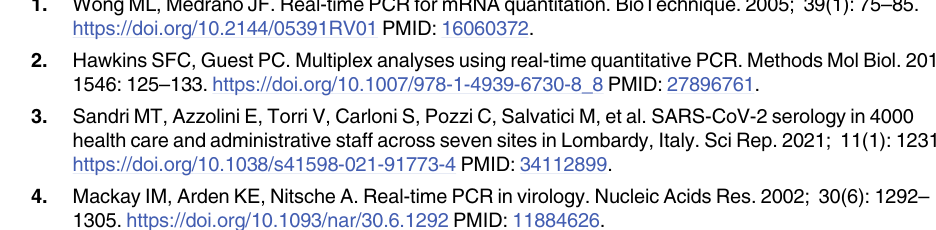
S1 Fig. Typical views of agarose gel electrophoresis of PCR products amplified by (A) relative and (B) absolute quantification showing the primer efficacy and specificity. The total RNA was purified from the central nervous systems (CNSs) of unconditioned snails. The reverse tran- scription was performed by RT Method 1 and 2 for the panel (A) and (B), respectively. PCR was performed in duplicate, and each sample was separated with a 2% agarose gel. The single bands of the PCR products of LymCREB1 (67 bp), LymCREB2 (142 bp) and LymCBP (63 bp) were observed at the length as expected, showing that the primer sets were enough efficient and specific. The arrowheads show the wells of the agarose